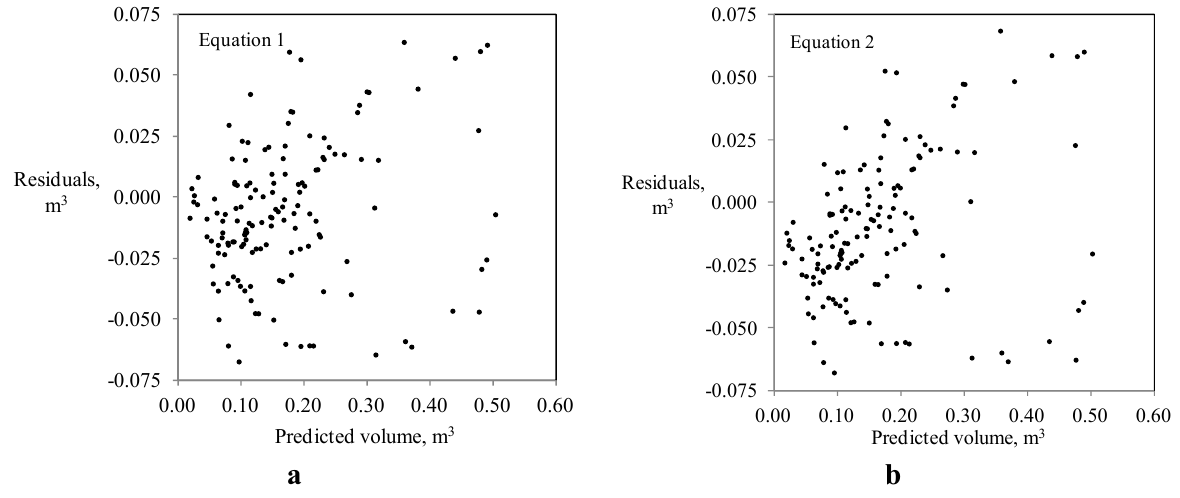
Figure 3. Residuals for the stem volume Equation 1 ( a ) and Equation 2 ( b ) for Norway